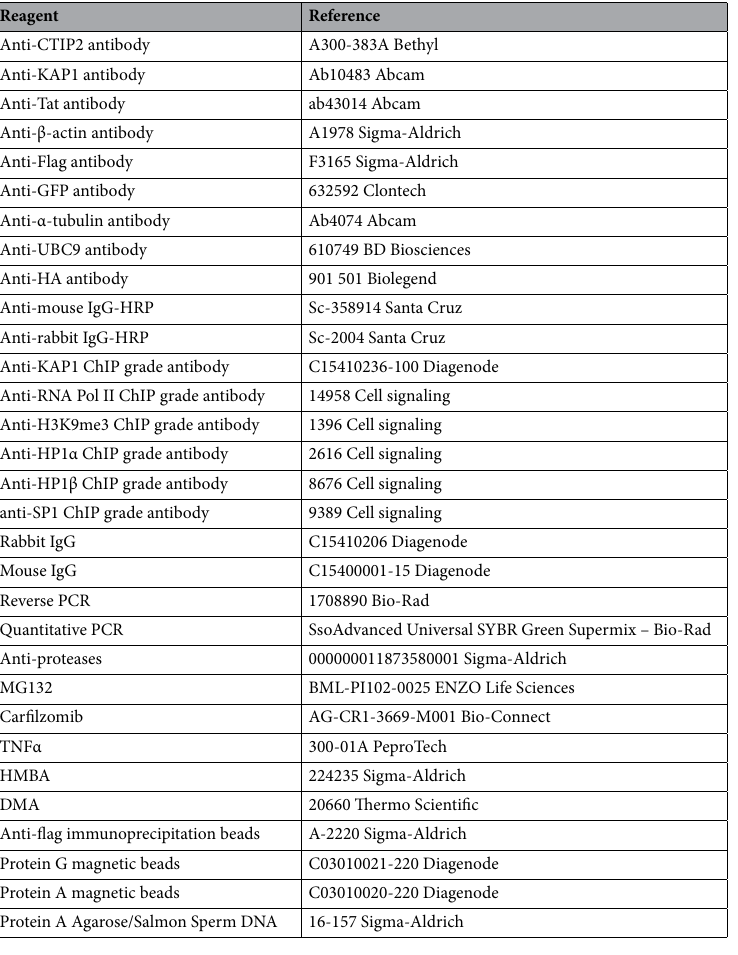
Table 1. Antibodies and